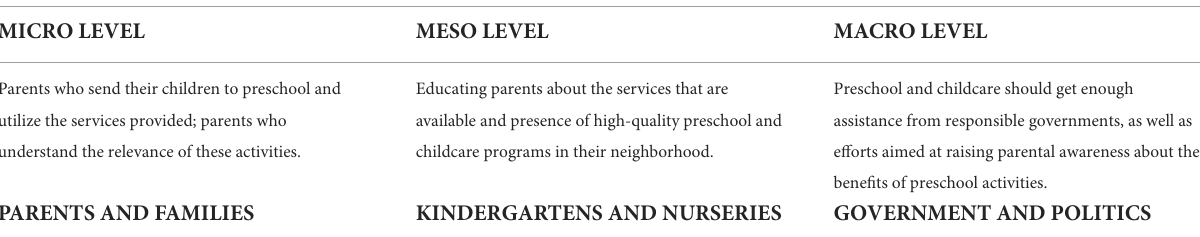
TABLE 1 SDG 4.2. targets: micro level, meso level, and macro level perspectives according to Boeren (2019). 2. “Ensure that all girls and boys have access to high-quality early childhood development, care, and pre-primary education by 2030 so that they are prepared for primary school” (SDG